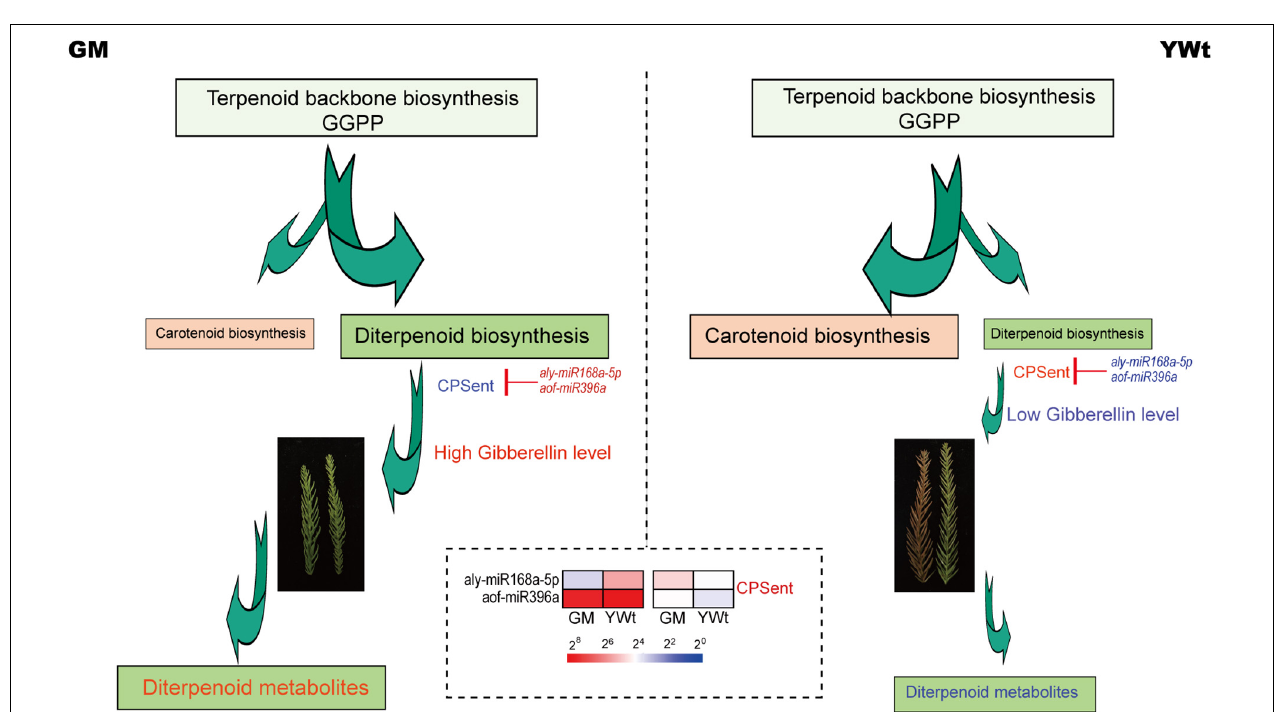
FIGURE 8 | Simplified model of aly-miR168a-5p- and aof-miR396a-CPSent regulating diterpenoid biosynthesis. Red/blue text indicates up-/downregulated genes; the sizes of the arrows indicate the amount of metabolic flow; and pseudo-color bar at the bottom of the middle represents the fragments per kilobase of exon